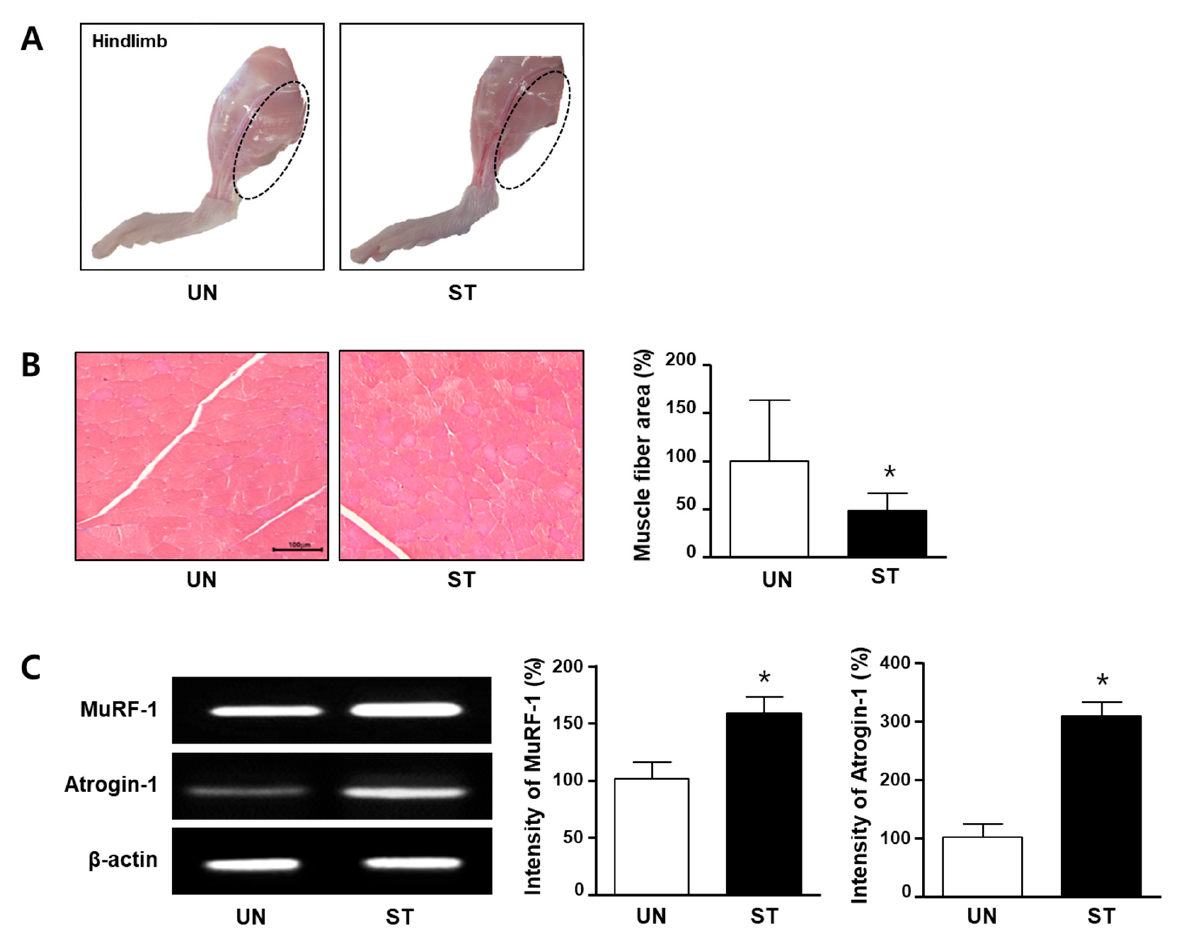
Figure 2. Histological analysis and mRNA expression of muscle RING-finger protein-1 (MuRF-1) and muscle-specific ligases atrophy F-box protein/atrogin-1 in the skeletal muscle of starved rat. The rats were divided into two groups: untreated (UN) and starved-for-48-h (ST) groups. ( A ) The animals were euthanized, and hindlimbs were isolated. The photographs indicate the comparison of muscle mass (dotted circle) in the UN ( n = 6) and ST groups ( n = 7). ( B ) The photographs represent muscle fiber area in the UN and ST groups using Masson’s trichrome (MT) stain. The graph expresses the number of muscle fiber area per field of the UN ( n = 3) and ST groups ( n = 3). ( C ) The mRNA expression levels of MuRF-1 and atrogin-1 were analyzed using reverse-transcription polymerase chain reaction ( n = 3). The bands indicate the levels of MuRF-1 and atrogin-1 expressions. Each graph is represented by measuring the bands on the left photograph. The data are expressed as average relative percentages compared with the untreated group ± standard deviations. * p < 0.05 vs. the UN group.